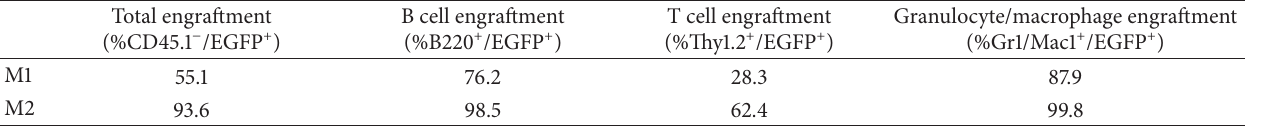
Table 3: Total and multilineage hematopoietic engraftment from a clonal population derived from a single EGFP + HSC. Total